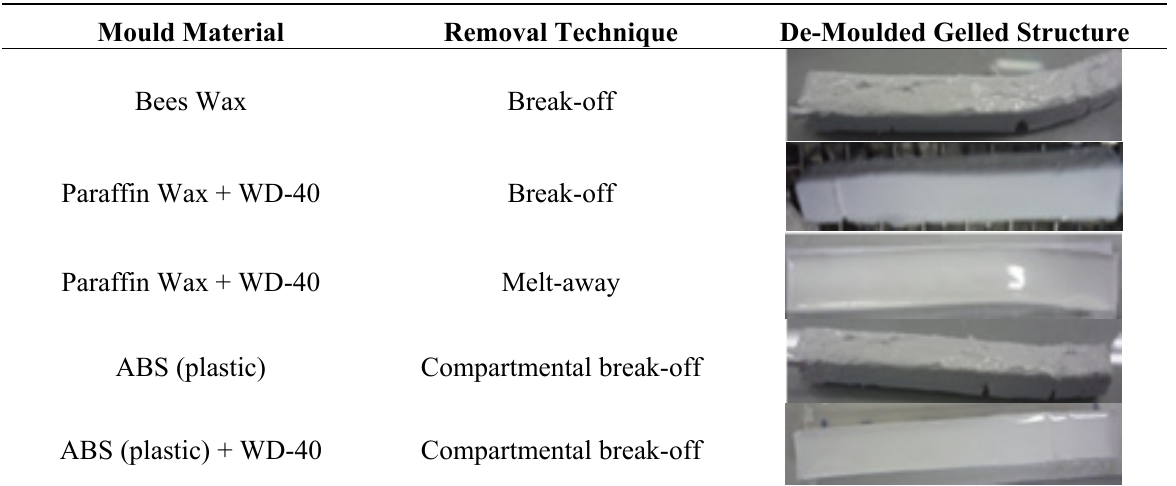
Table 1. Qualitative comparison of various mould materials and removal